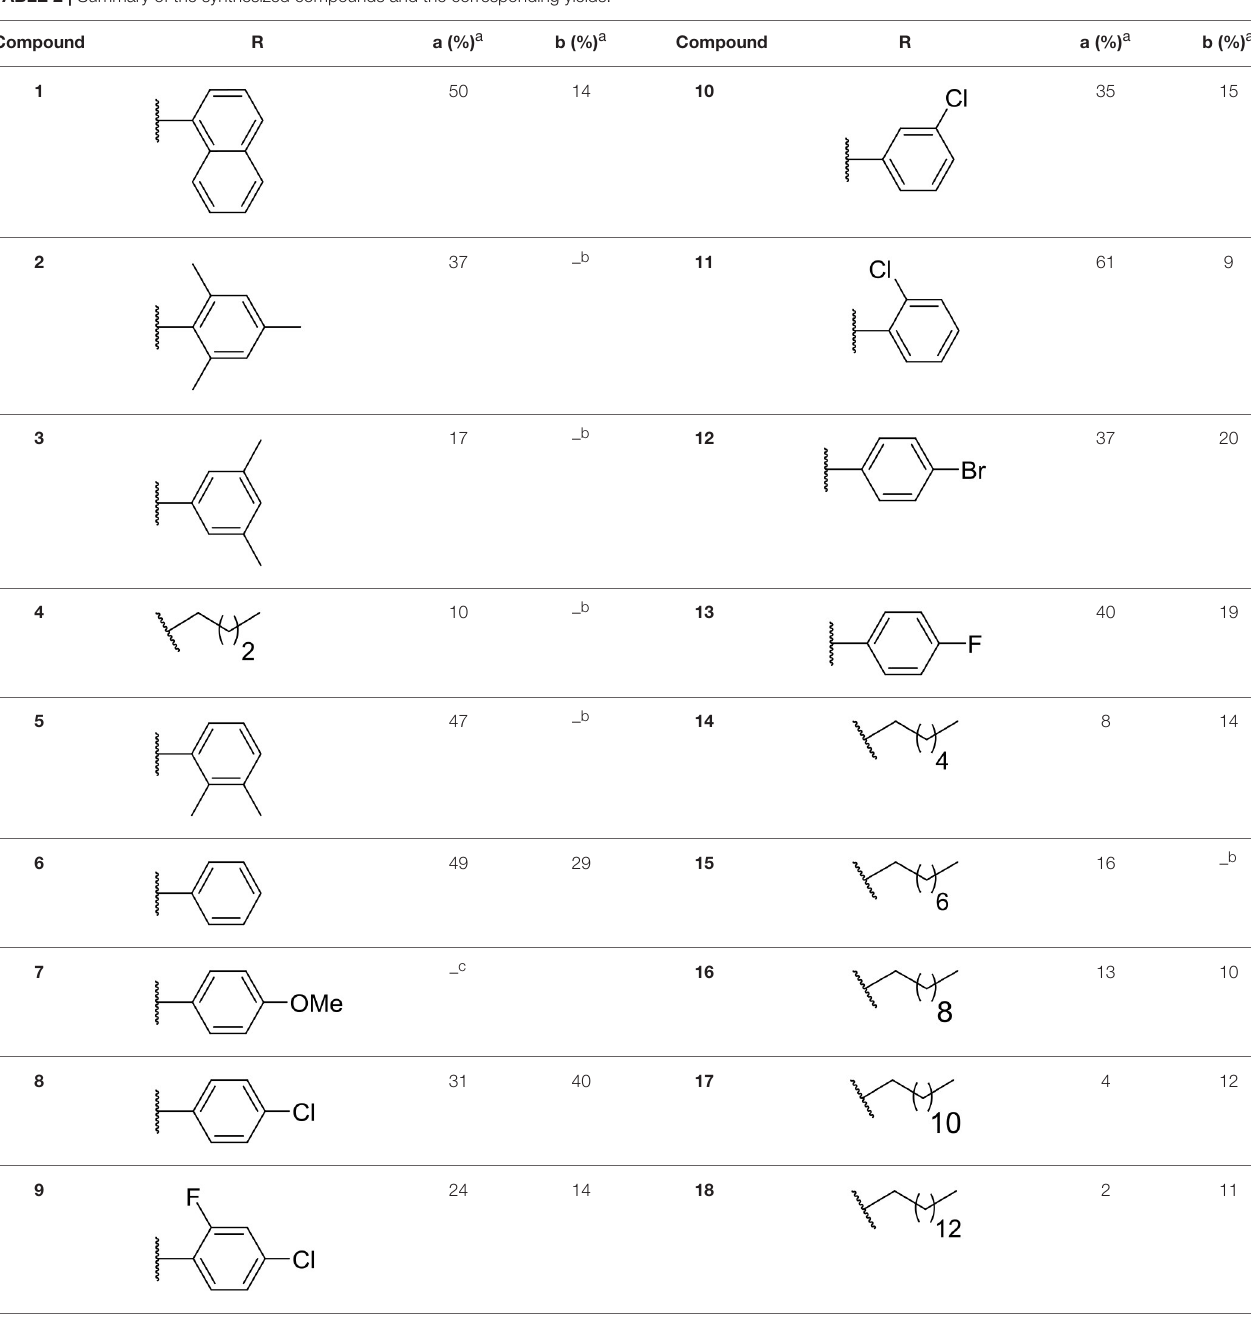
TABLE 2 | Summary of the synthesized compounds and the corresponding yields.